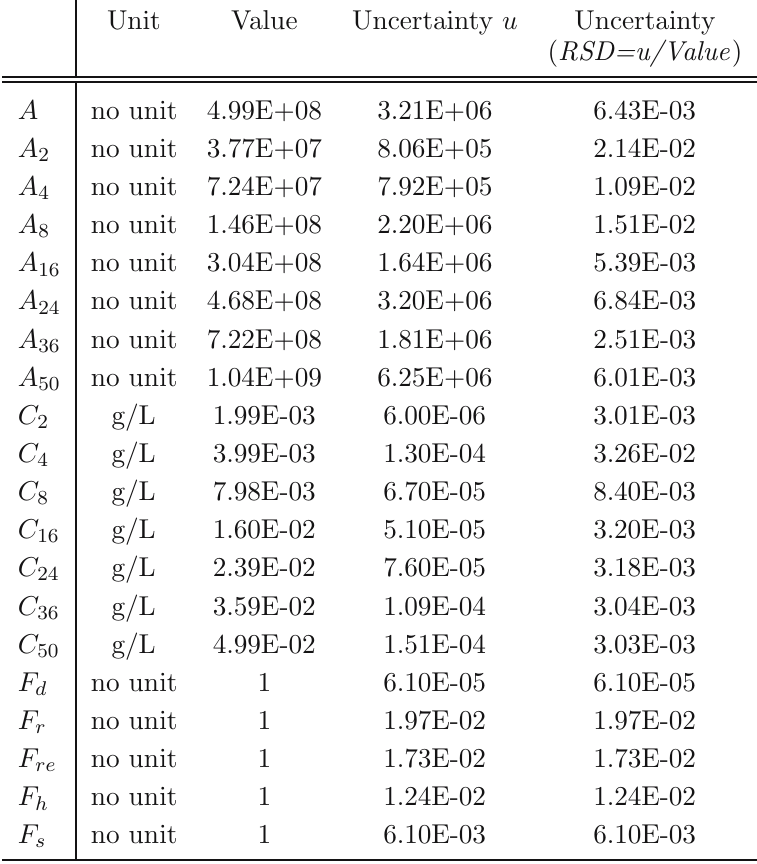
Table 5 Uncertainty components and their relative standard uncertainty regarding ni- trate